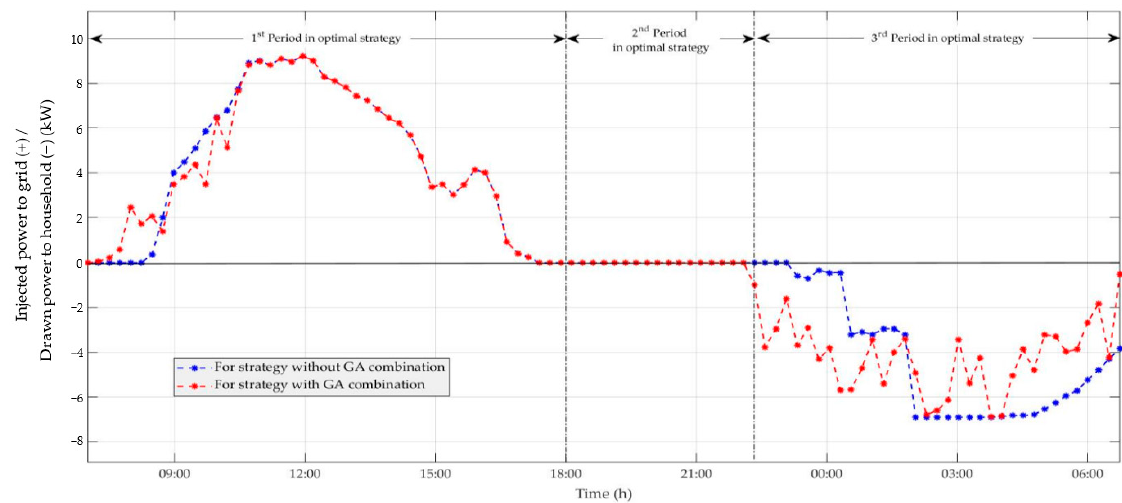
Figure 15. Comparison of interaction powers using strategies with and without the GA.